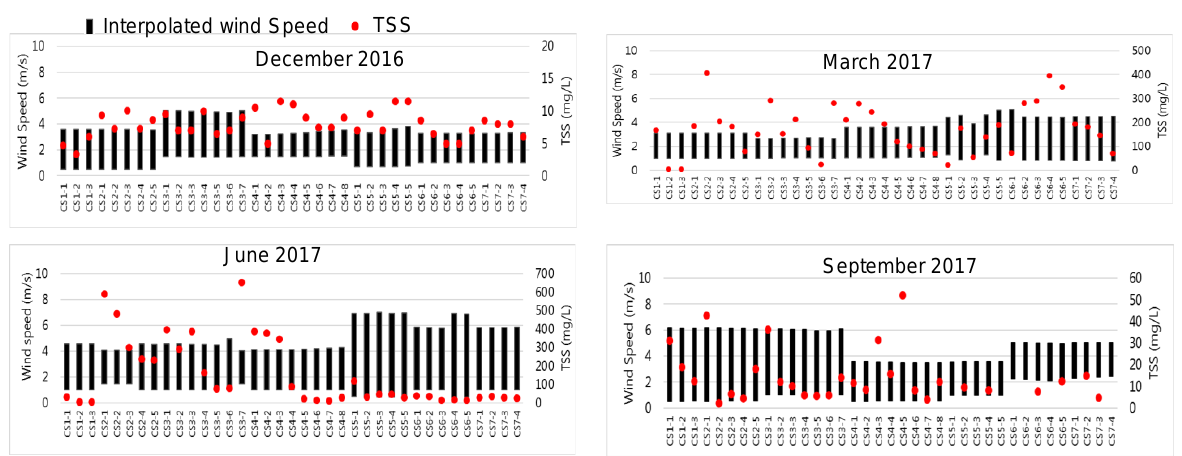
Figure 3. Interpolated wind speed and total suspended solids (TSS) concentration across Tonle Sap Lake, Cambodia.